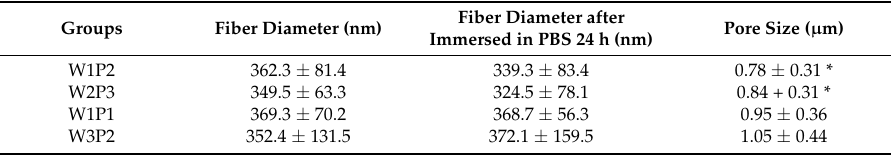
Table 1. The average electrospun fiber diameter and pore size of fibers obtained using different volume ratios ( v / v ) of WPU to PEO: The fiber diameters after treatment in PBS for 24 h are also shown. There was no significant difference in the fiber diameter ( p > 0.05) among different groups before or after PEO removal by PBS immersion. W1P2 and W2P3 showed significantly smaller pore sizes when compared to W3P2.